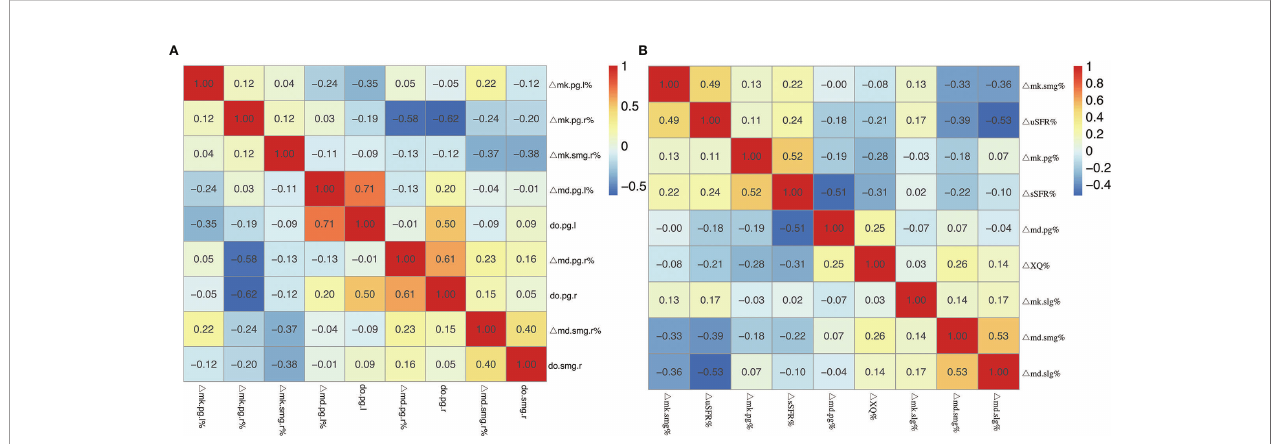
FIGURE 6 | (A) Heatmap of the correlation coef fi cients between the change ratio of DKI metrics (MD and MK) from pre-RT to post-RT and dose of bilateral salivary glands. (B) Heatmap of the correlation coef fi cients between the change ratio of DKI metrics (MD and MK) of the salivary glands and the change ratio of uSFR, sSFR, and XQ scores from pre-RT to post-RT. Abbreviations are referred to in Table 2 .